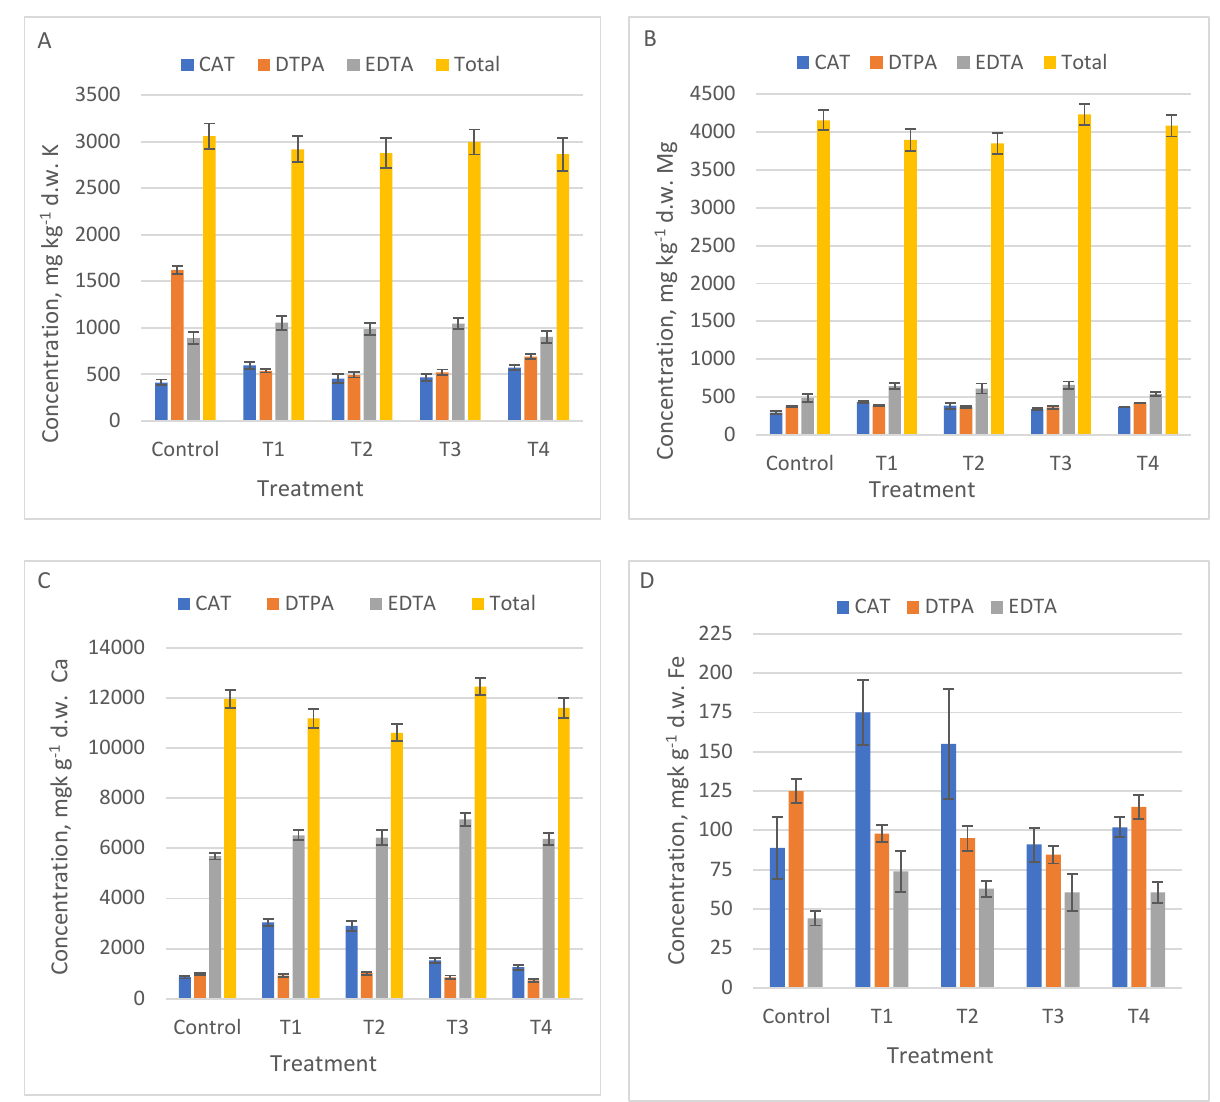
Figure 2. The mobile metallic concentration of micronutrients in Control, and T1 to T4 treatments using three single chem- ical extraction procedures: DTPA, CAT, EDTA compared to total content, (average ± SD, n = 3): ( A ) Zn, ( B ) Cu, ( C ) Mn.